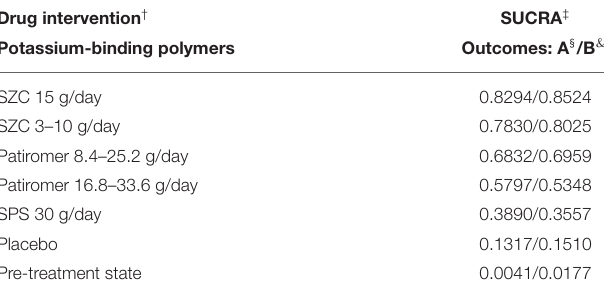
compared to placebo according to the values of ORs and their corresponding 95% CrIs considering normokalemia (sK + 3.5